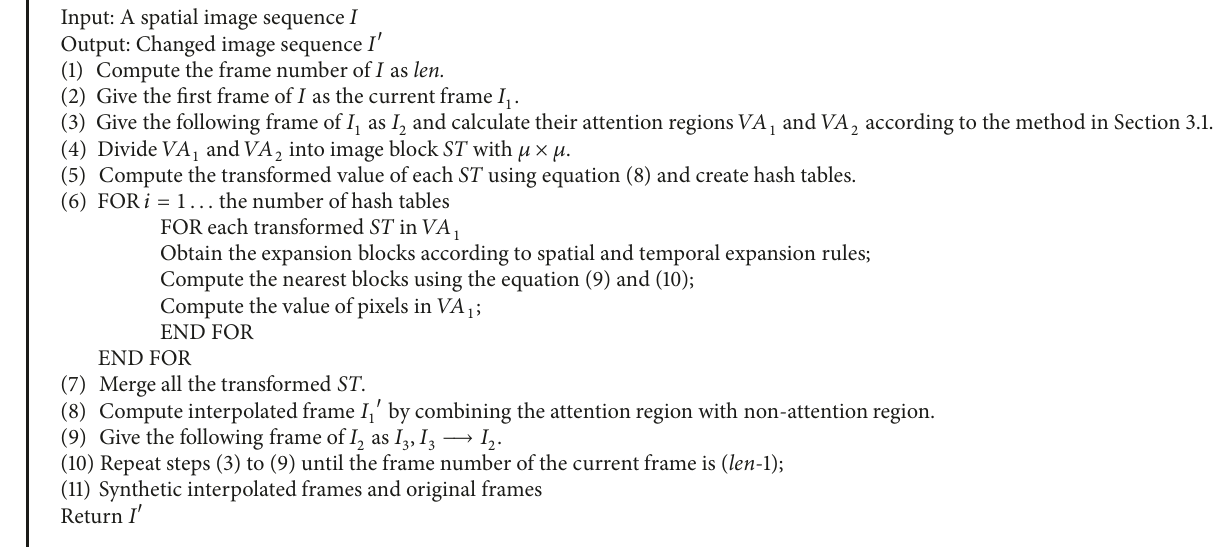
Algorithm 1: Frame rate conversion